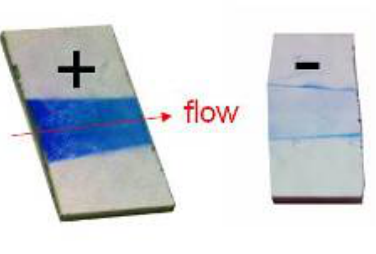
Figure 4. Resonance color obtained by nanoparticle binding in the test system–fluidic cell.